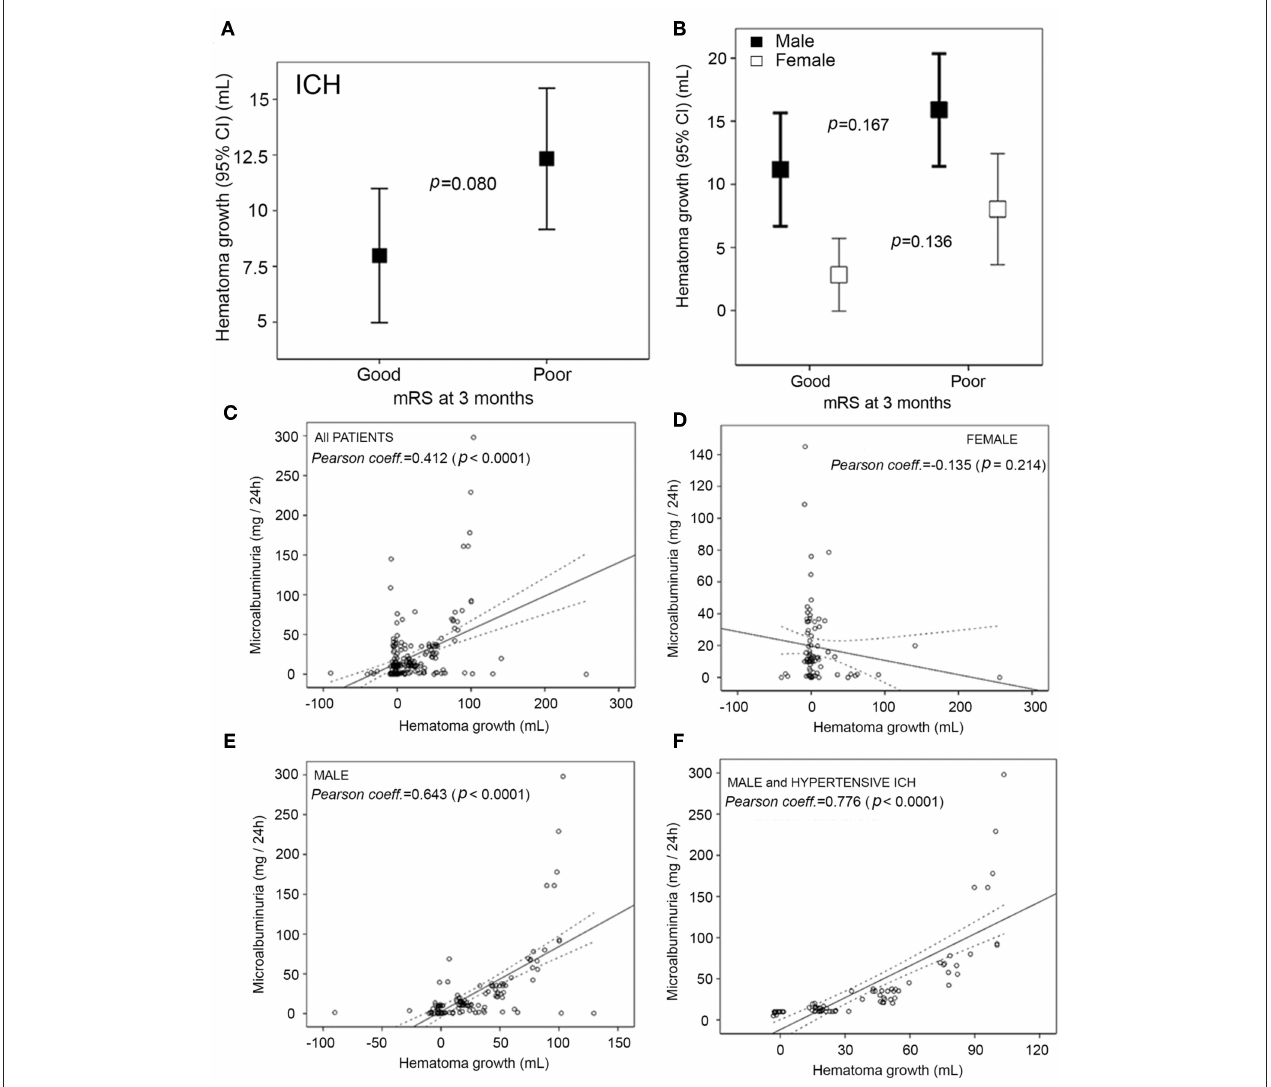
FIGURE 3 | (A) Hematoma growth in good and poor outcome patients. (B) Sex-related difference in hematoma growth in 3-months good and poor outcome patients. (C–F) Correlation between hematoma growth and endothelial dysfunction marker in all patients, female, male and male with intracerebral hemorrhage of hypertensive etiological origin.